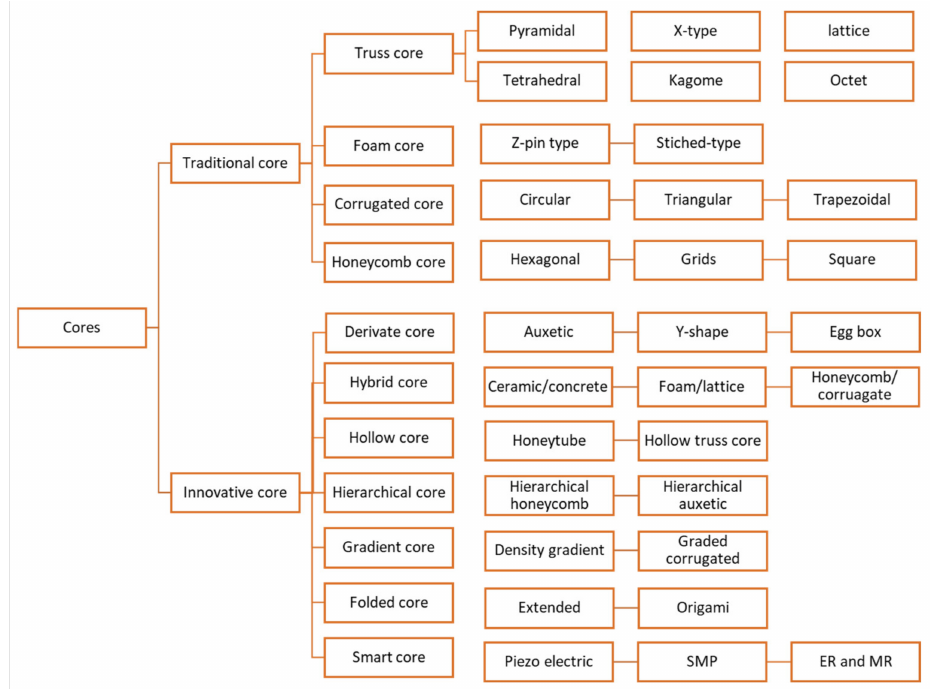
Figure 3. Types of